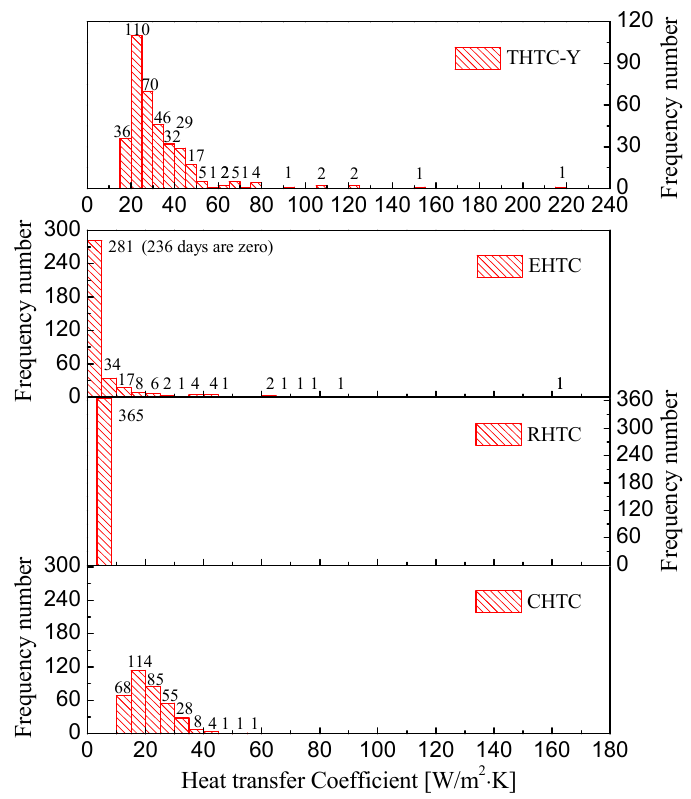
Figure 12. Frequency distribution of daily average heat transfer coefficient.